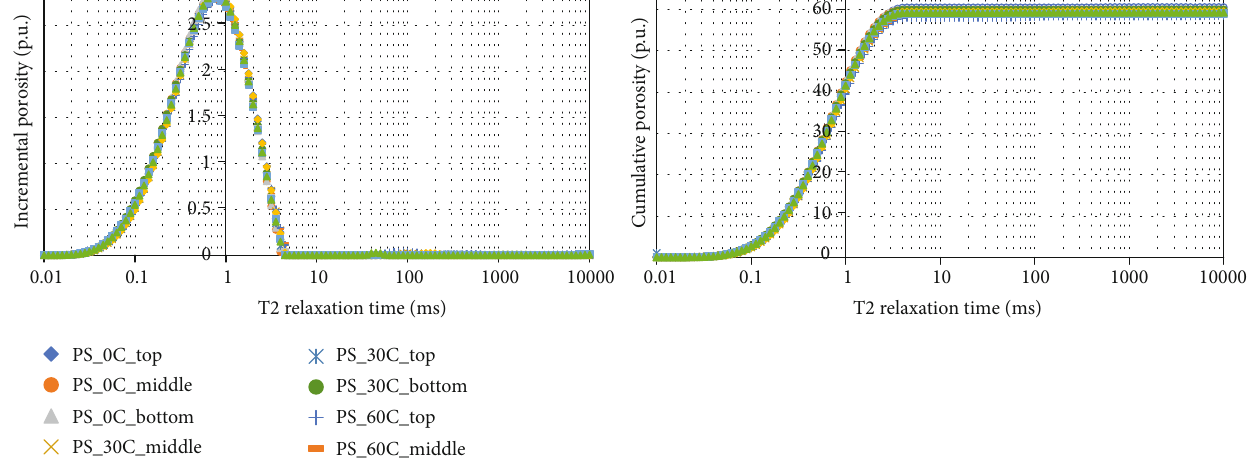
Figure 8: Pore space